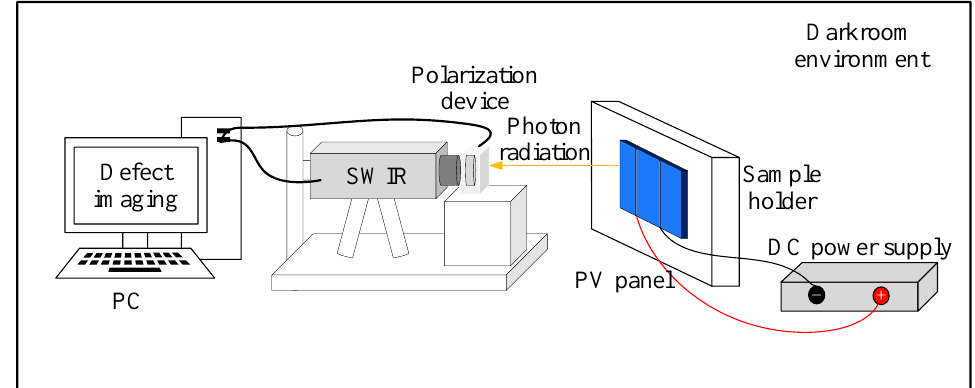
Figure 3. Schedule of the electroluminescence polarization experimental platform.